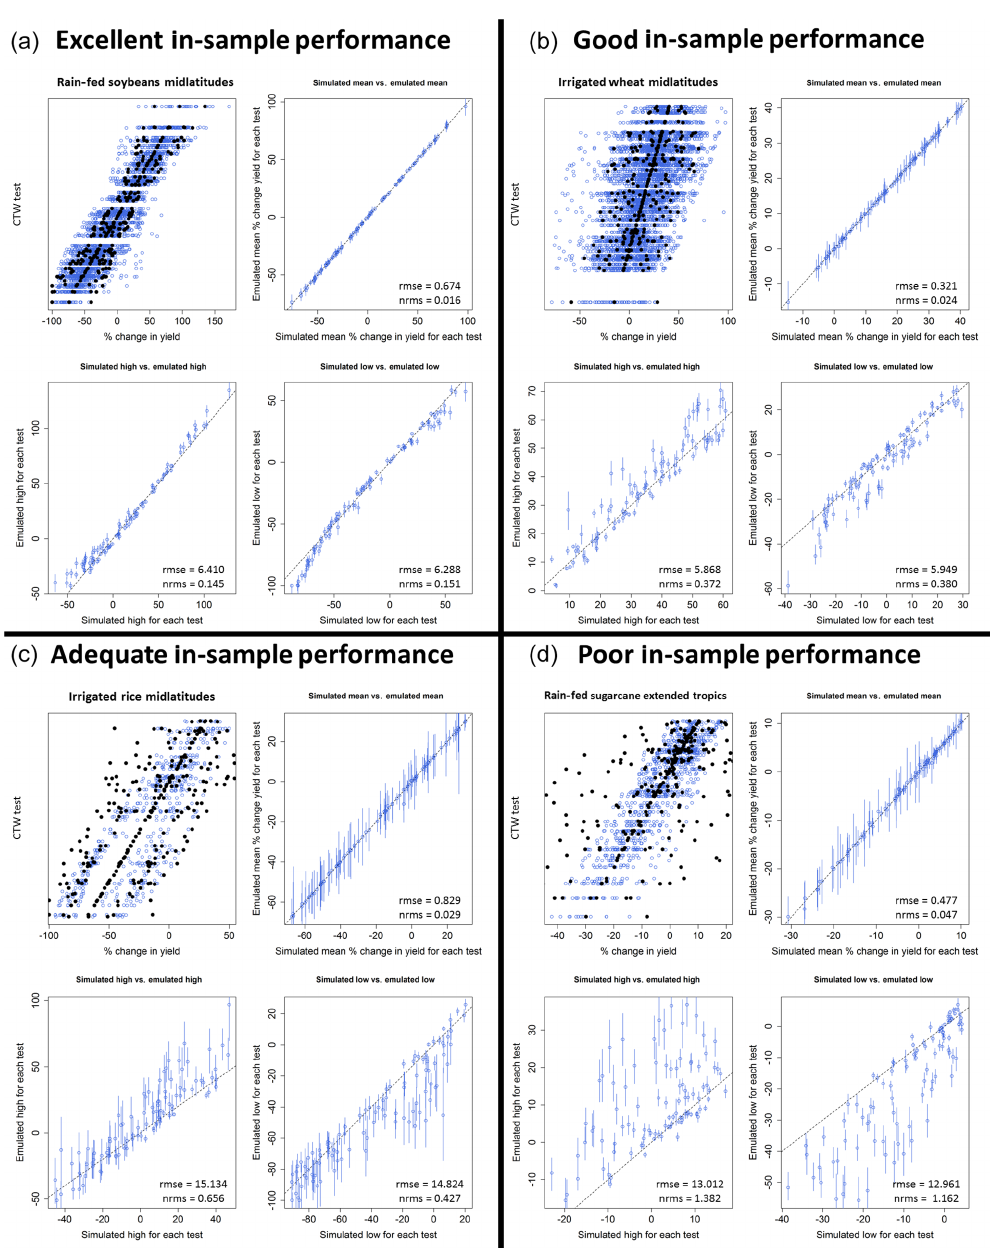
Figure 4. (a) Rain-fed soybeans in the midlatitudes, an example of the excellent in-sample performance category. (b) Irrigated wheat in the midlatitudes, an example of the good in-sample performance category. (c) Irrigated rice in the midlatitudes, an example of the adequate in-sample performance category. (d) Rain-fed sugarcane in the extended tropics, an example of the poor in-sample performance category (also seen in Fig. 5a). Vertical error bars indicate the 95% credible interval for each of mean, high, and low emulated